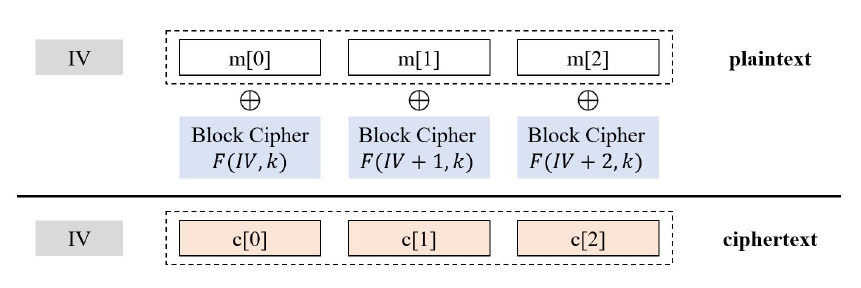
Figure 2. Block cipher in counter (CTR)